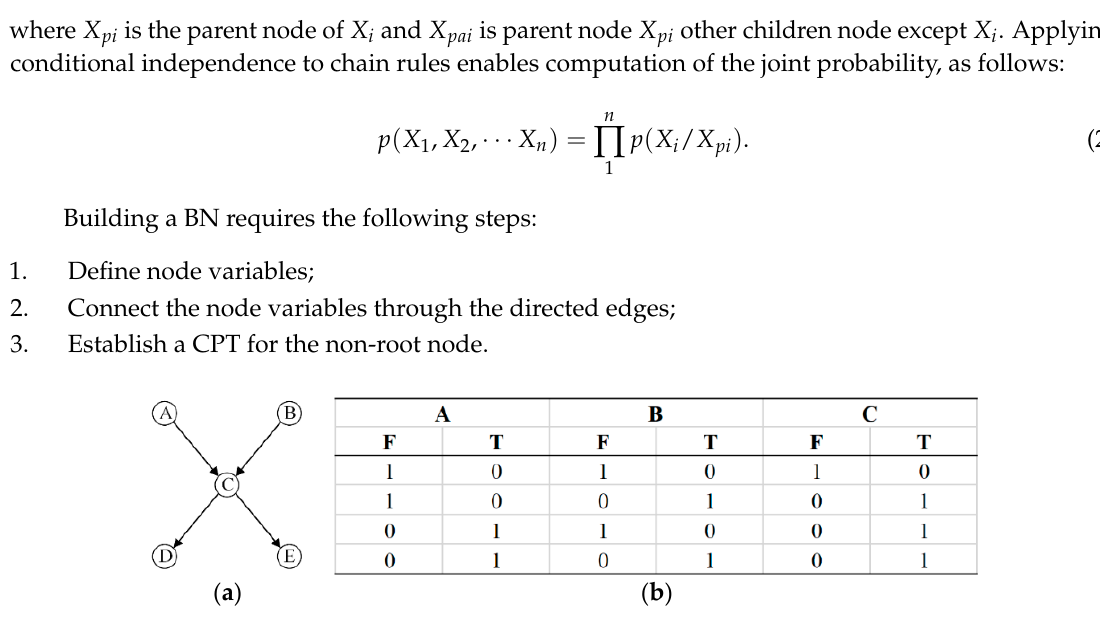
Figure 1. 5-node directed acyclic graph and conditional probability table. ( a ) 5-node directed acyclic graph; ( b ) Conditional probability table.